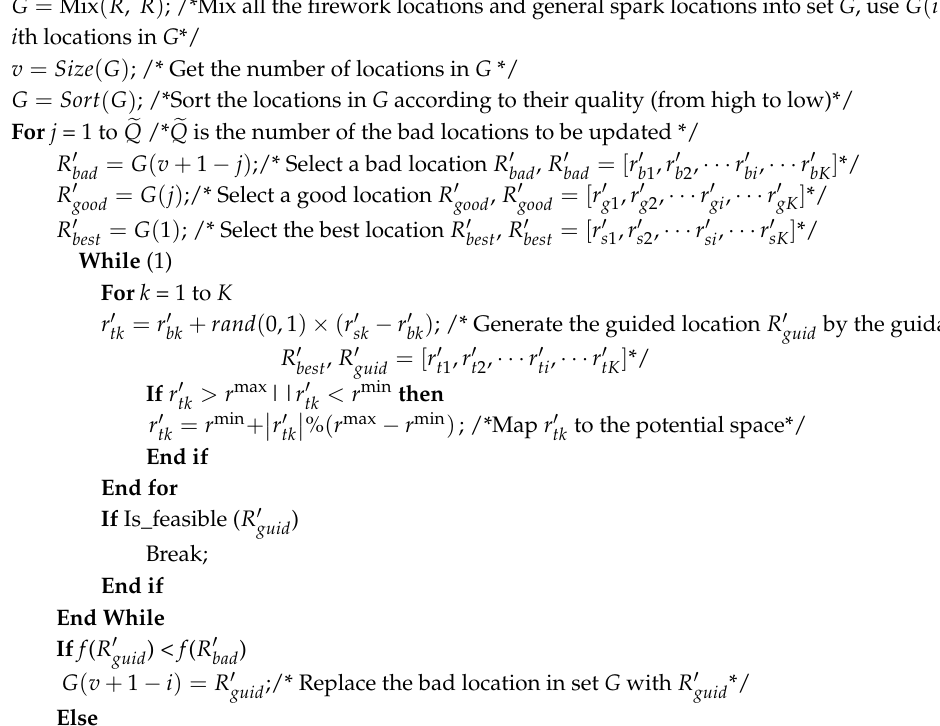
Algorithm A3 Generate the locations of guided sparks G = Mix ( R , ˆ R ) ; /*Mix all the firework locations and general spark locations into set G , use G ( i ) to present the i th locations in G